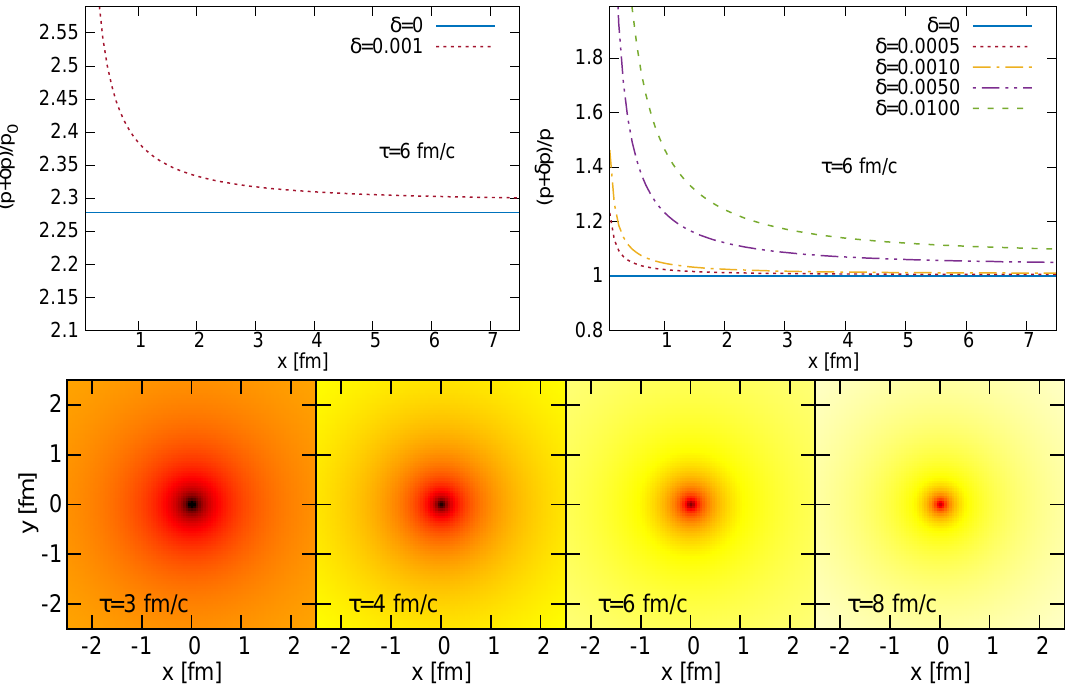
Figure 2. The perturbed pressure p + δ p is shown in the left plot as a function of x , for τ = 6 fm/ c (the other parameters are given in the text). The right plot indicates the relative change ( p + δ p ) / p for various δ and c values. The bottom plot shows the pressure perturbation δ p in the transverse plane, for various proper-time